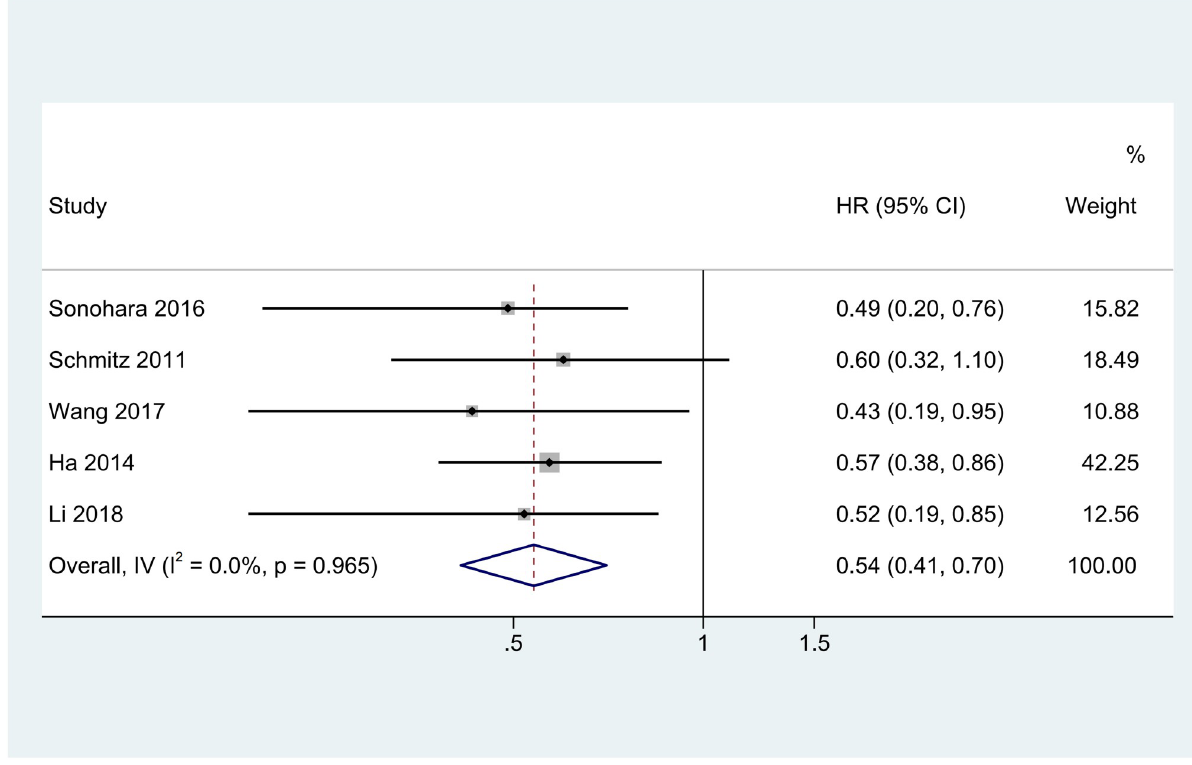
PLOS ONE | https://doi.org/10.1371/journal.pone.0279591 December30,